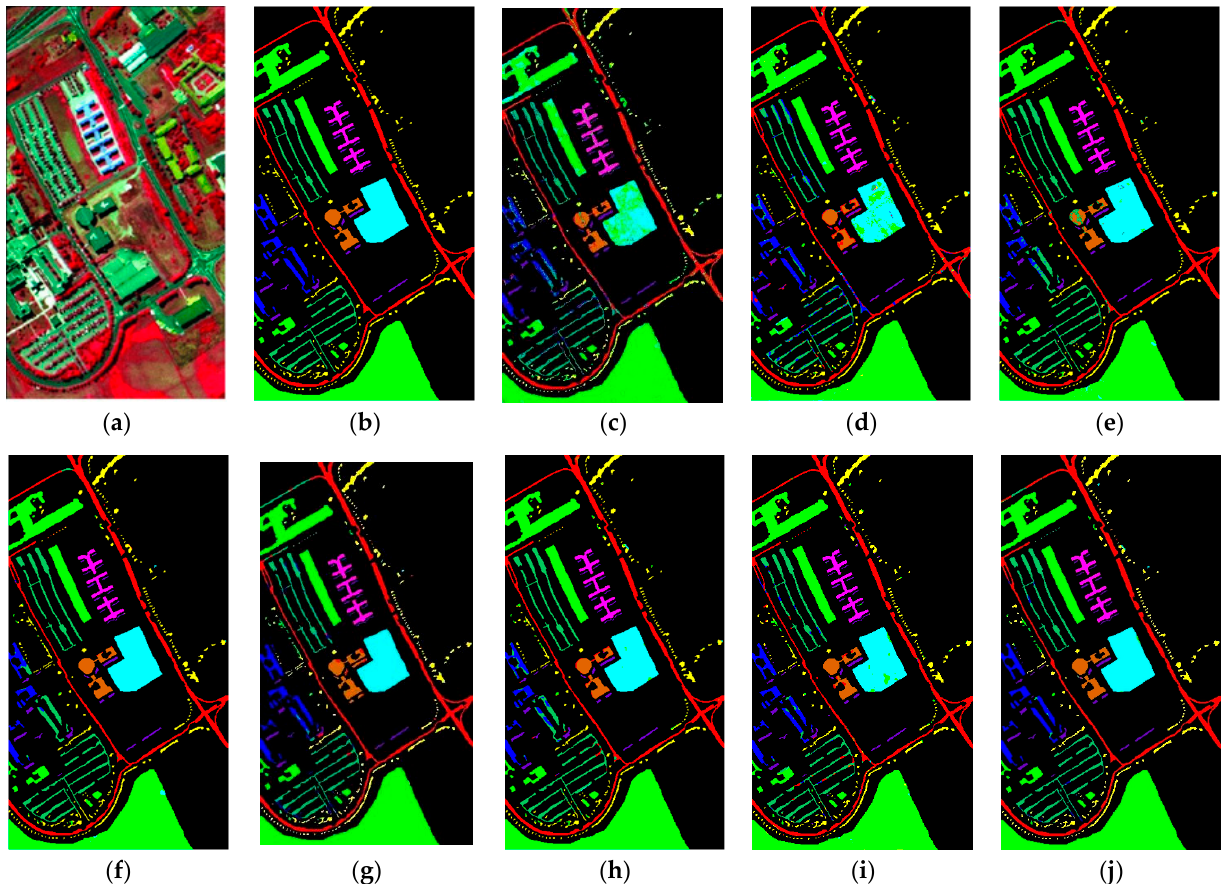
Figure 6. The classification map of Pavia University. ( a ) False-color image; ( b ) ground truth; ( c ) SVM; ( d ) CDCNN; ( e ) SSRN; ( f ) FDSSC; ( g )HybirdSN; ( h ) DBMA; ( i ) MCNN; ( j ) the proposed method.